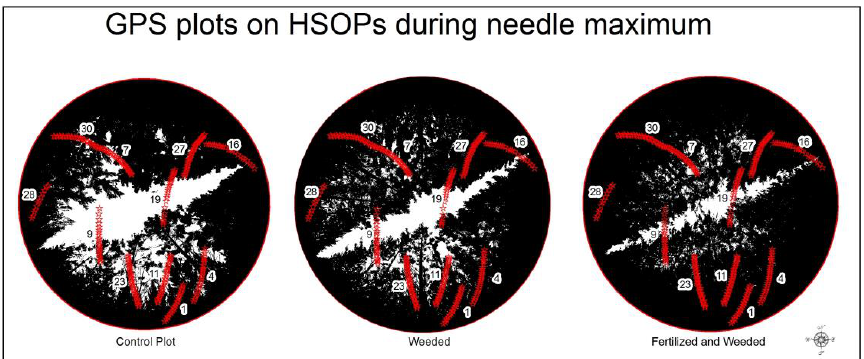
Figure 5. The resulting binary images taken at the Intensive Management Practice Assessment Center managed forest taken during the needle maximum period with the GPS satellite vehicle positions (red circles) plotted inside the image.